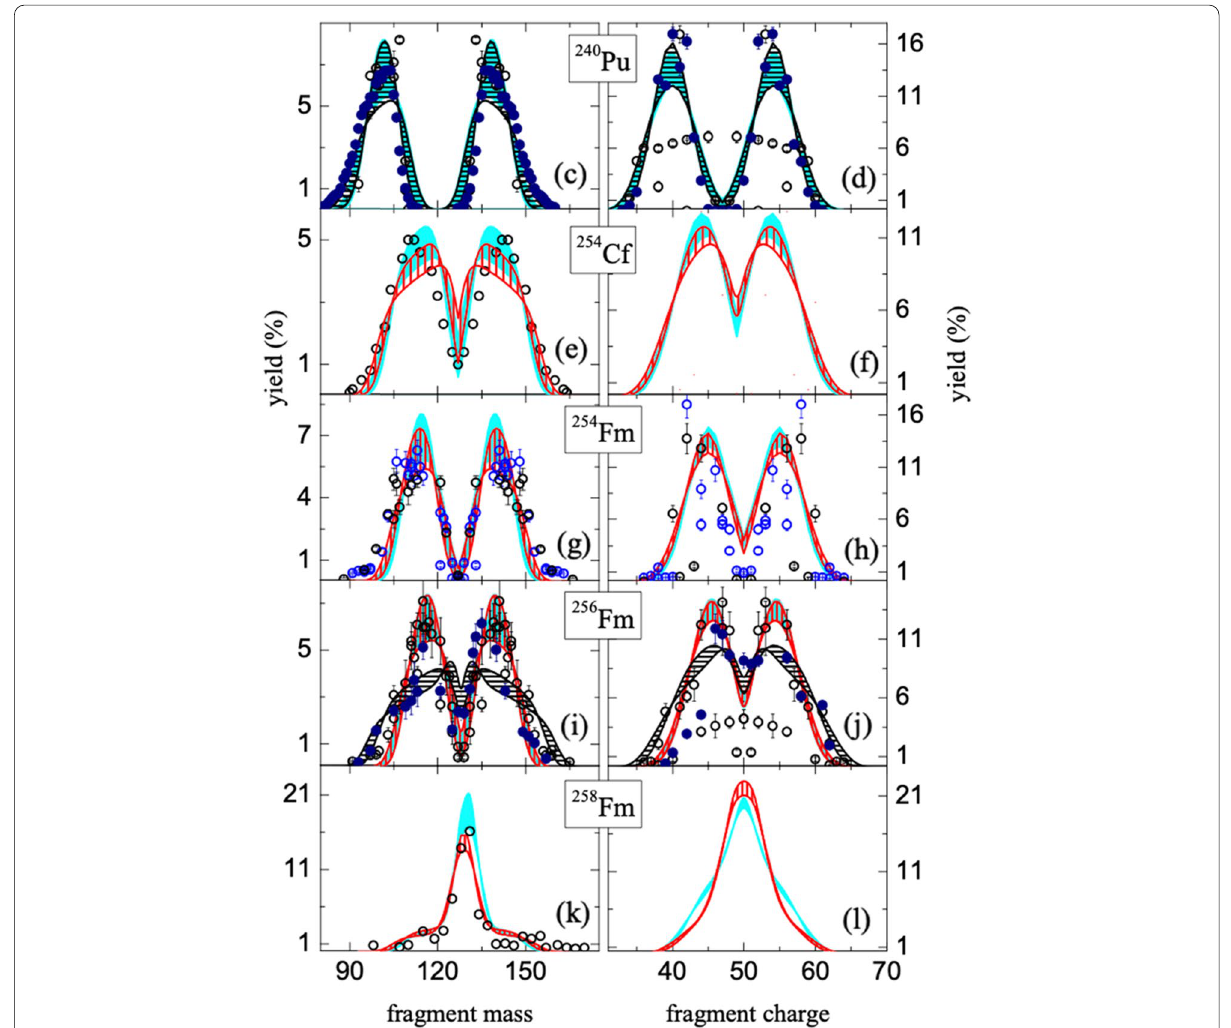
Fig. 18 Calculated yield distributions for SF (shaded for SkM * and vertically patterned for UNEDF1 HFB ) and thermal fission (horizontally patterned) with theoretical uncertainty of two nucleons in each prefragment. Symbols indicate experimental data as specified in Ref. [67]. The figure is adapted from